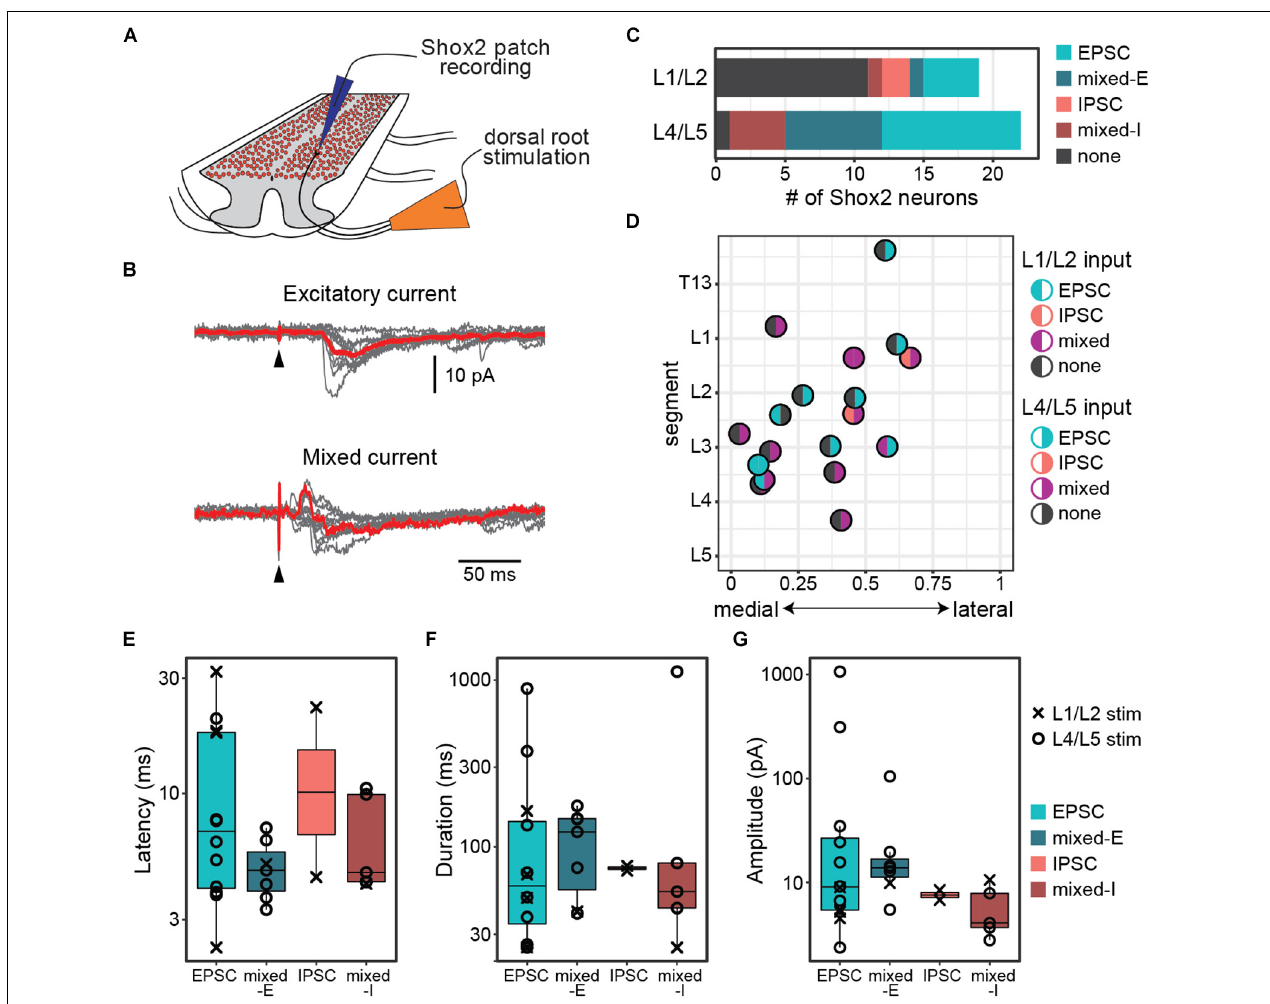
FIGURE 1 | Postsynaptic currents are detected in Shox2 neurons following dorsal root stimulation. (A) Cartoon of experimental setup for the ventral horn-removed experiments. Dorsal roots were stimulated while recording from Shox2 neurons (red) in lumbar segments of cords isolated from Shox2::cre;Rosa26-lsl-tdTomato mice. (B) Postsynaptic currents were recorded in Shox2 neurons in response to stimulation of rostral (L1 or L2) and/or caudal (L4 or L5) lumbar dorsal roots. Evoked currents in Shox2 neurons were only excitatory (EPSC), only inhibitory (IPSC), or mixed with shortest latency components that were excitatory (mixed-E) or inhibitory (mixed-I). Top: example showing excitatory current. Gray traces show 10 individual trials and red trace shows average. Black triangle indicates stimulation artifact. Bottom: example showing mixed-I current. (C) Number of recorded Shox2 neurons displaying postsynaptic currents in response to stimulation of dorsal L1/L2 (8/19) and L4/L5 roots (21/22). (D) Responses of Shox2 neurons in which both L1/L2 and L4/L5 stimulation were tested are plotted according to lumbar level and mediolateral position. The color of each point is based on response (EPSC in teal, IPSC in pink, mixed in purple, and gray for no response) following L1/L2 (left half) and L4/L5 (right half) stimulation. The center point of the dorsal root at the entry zone is designated as segment number. (E–G) Latency, duration, and amplitude were characterized for each response to L1/L2 (x) and L4/L5 (o) stimulation and plotted on log scale for better visualization of